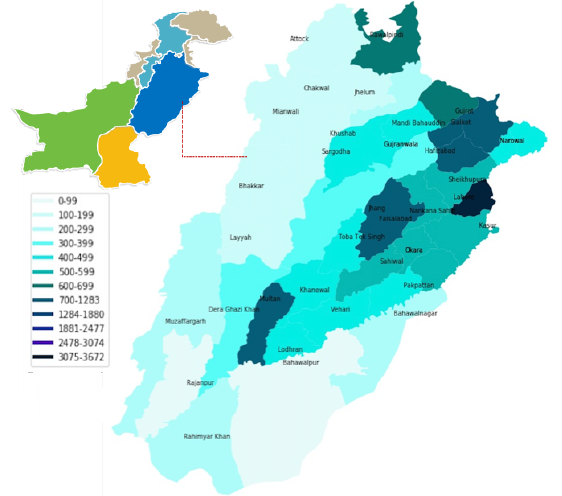
Figure 1. Punjab, a province of Pakistan, is identified as the study area with population density for different districts. Punjab is the highest populus province of Pakistan with 38 districts.